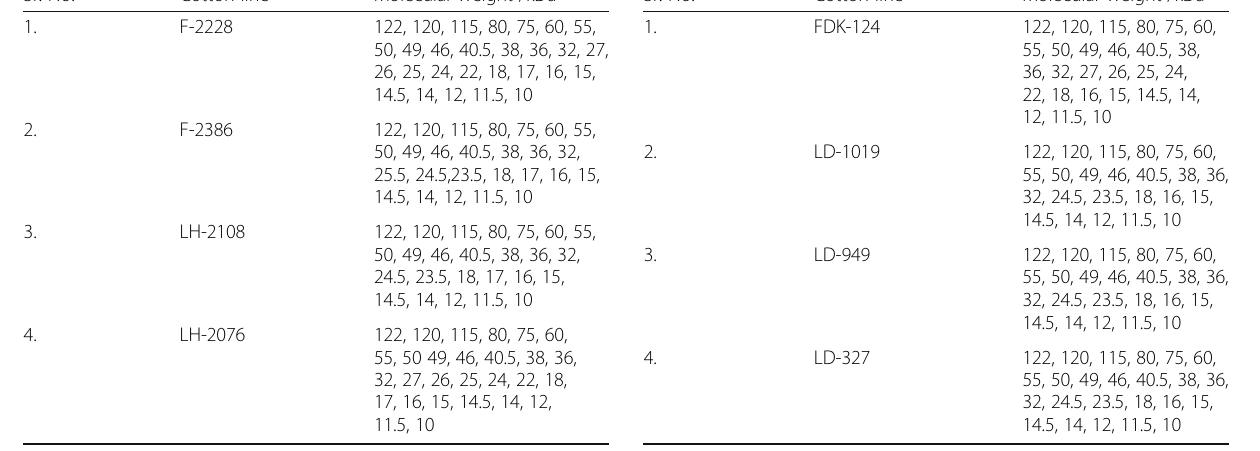
Table 5 Molecular weight of polypeptides in seed protein extracts of G. arboreum under reducing conditions Sr.